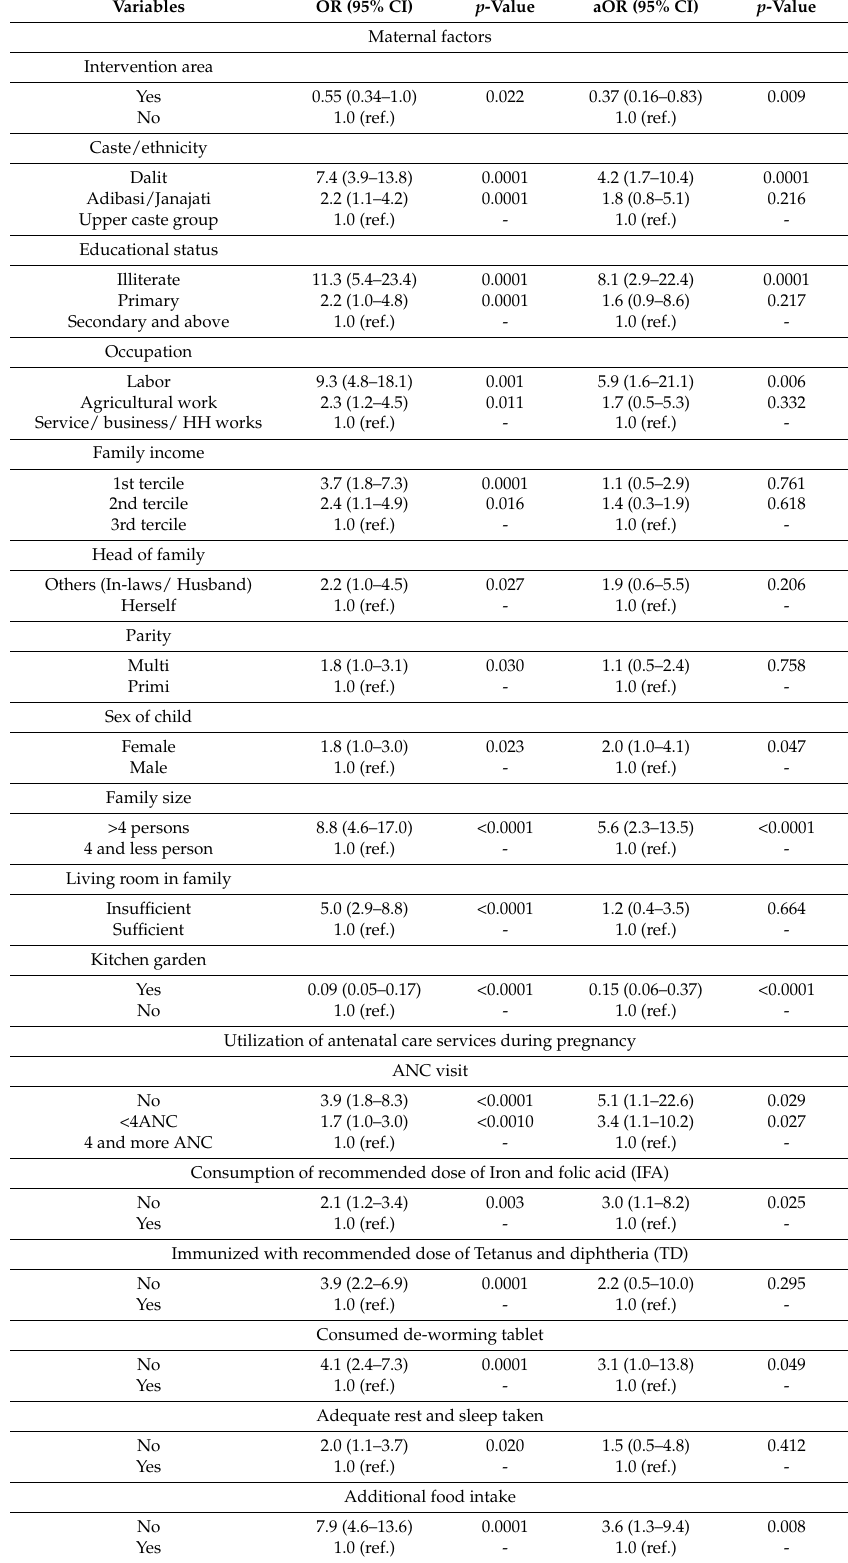
Table 3. Relations between low birth weight (LBW) and maternal factors and the utilization of antenatal care services during pregnancy, by logistic regression analysis